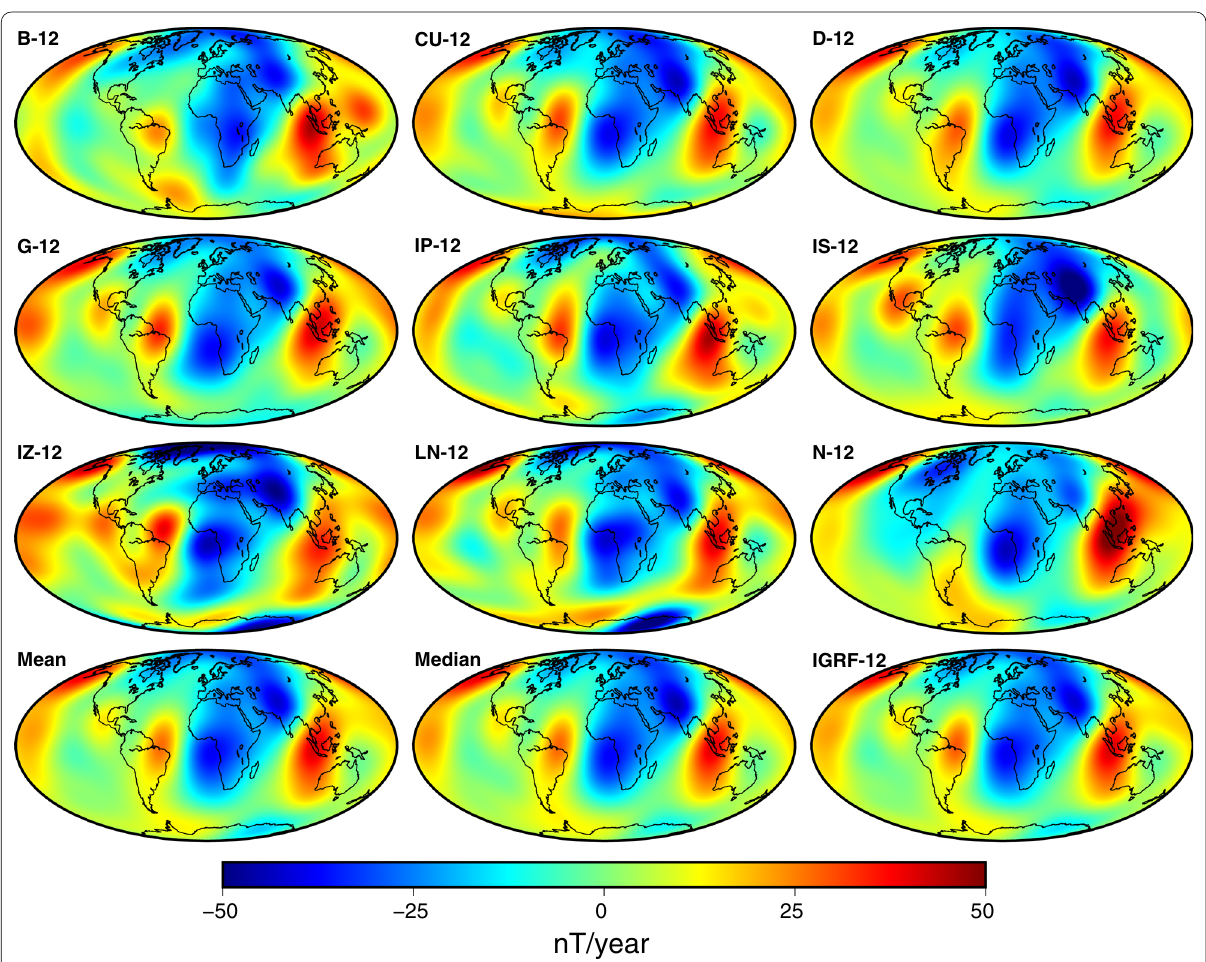
Fig. 13 Spatial map differences of d B z / d t (in nT/year) between IGRF-12 secular variation candidates and final IGRF-13 secular variation model over the 2015.0 to 2020.0 time period. We additionally include spatial map differences (against IGRF-13) of the mean and median of all IGRF-12 candidates, as well as the final IGRF-12 SV model in the bottom